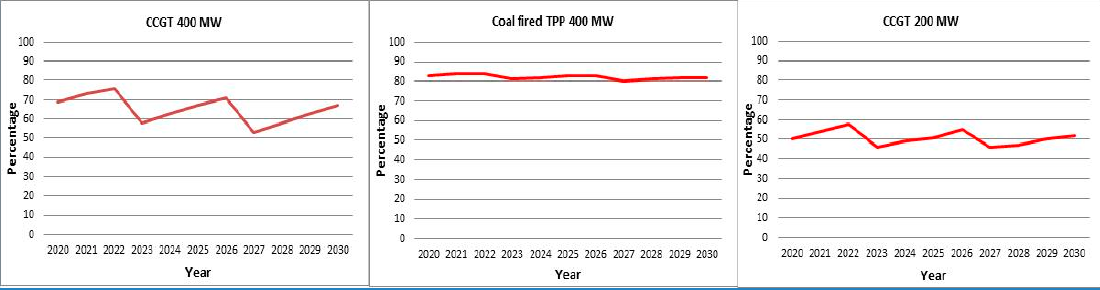
Figure 13. Load factor of new power plants in a scenario with LOLP = 1% and VOLL $2 USD/kWh.